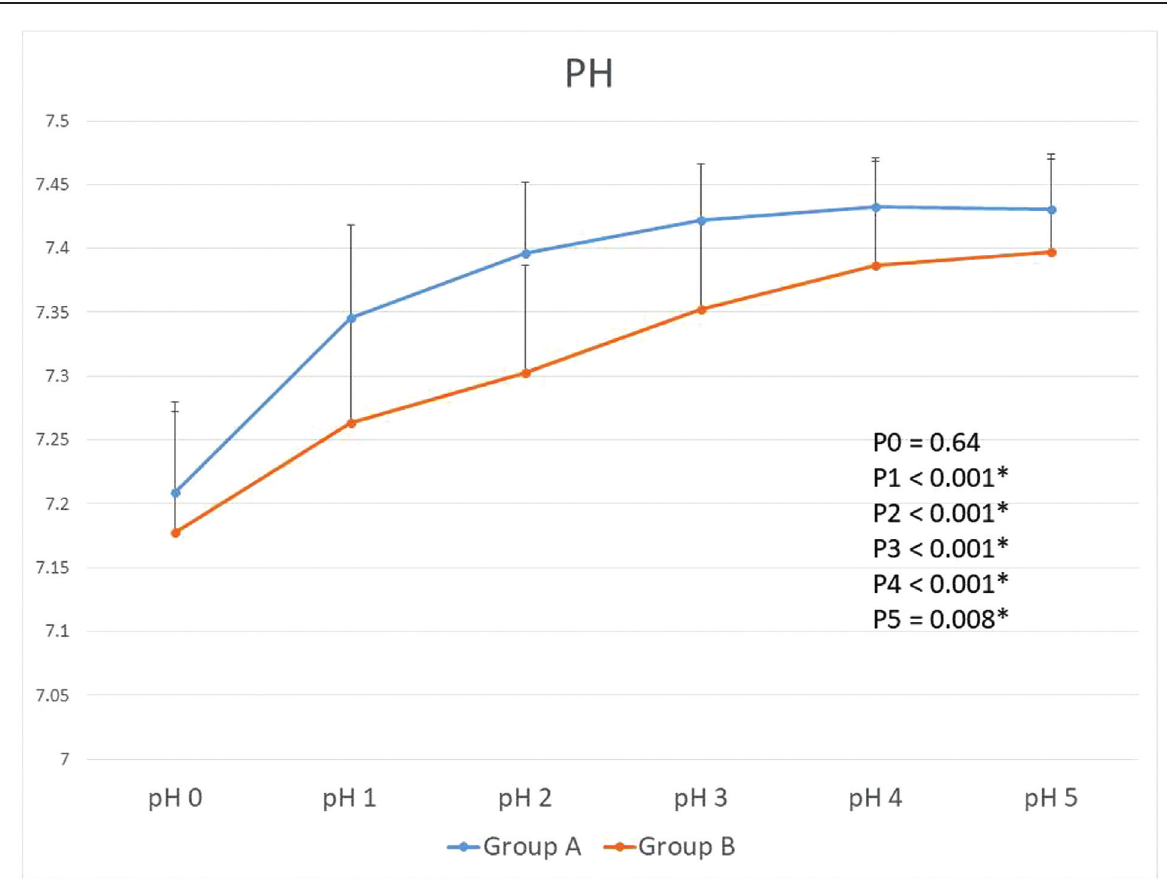
Effect of sedation on pH. Data are expressed as mean±SD. Group A: sedation group, group B: no-sedation group. P value less than 0.05 is considered statistically significant. pH_0 = baseline pH at intubation, pH_1 is pH 1h after intubation, pH_2 is pH 2h after intubation, pH_3 is pH 12h after intubation, pH_4 is pH 24h after intubation, and pH_5 is pH 48h after